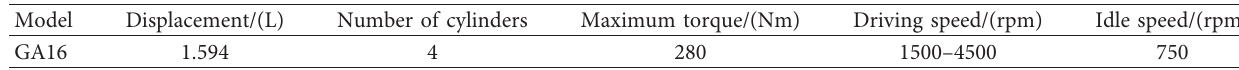
Figure 4: Torsional vibration model under driving conditions. Table 1: Engine parameters.